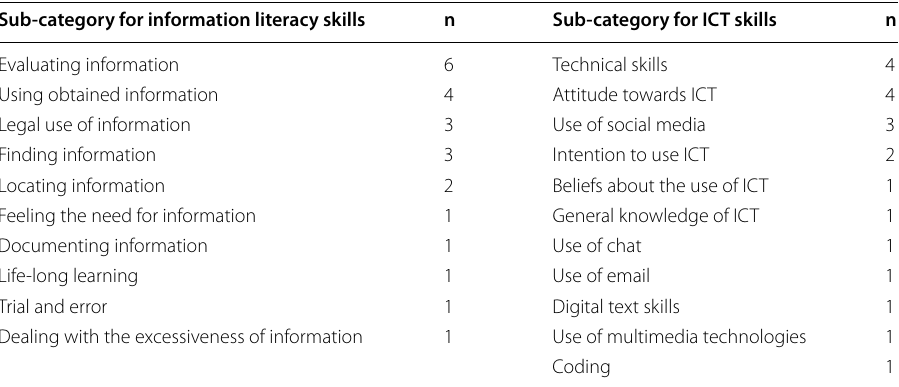
Table 6 Sub‑categories under ‘information literacy’ and ‘ICT’ skills Sub-category for information literacy skills